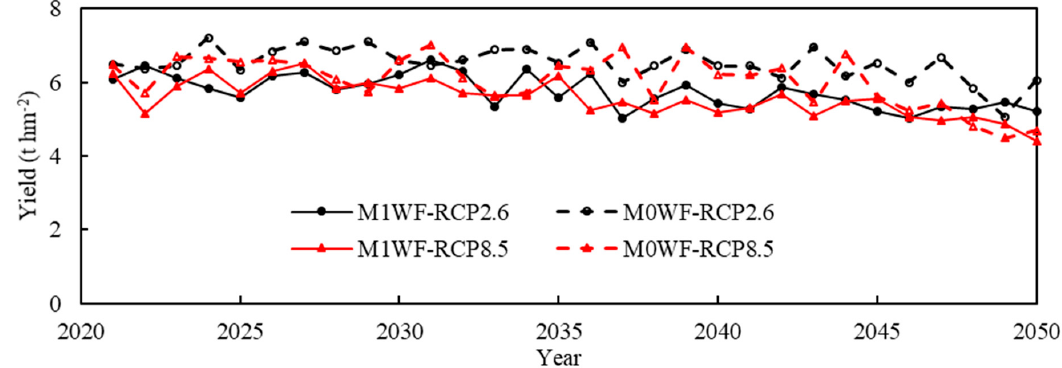
Figure 8. Temporal variations of the seed-maize yield under the RCP2.6 and RCP8.5 scenarios.